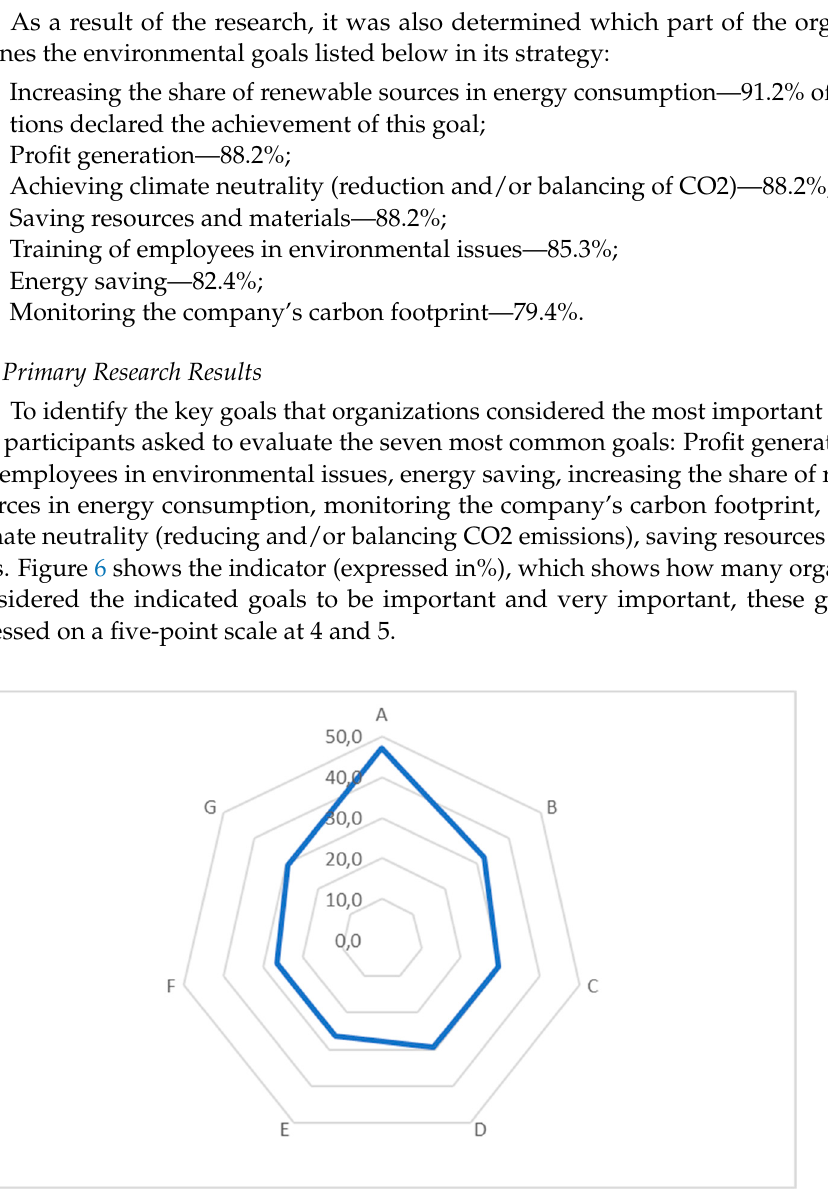
Figure 6. Percentage of organizations that assessed the indicated goals as significant and very important from the point of view of the implementation of their strategy (4—significant and 5—very important